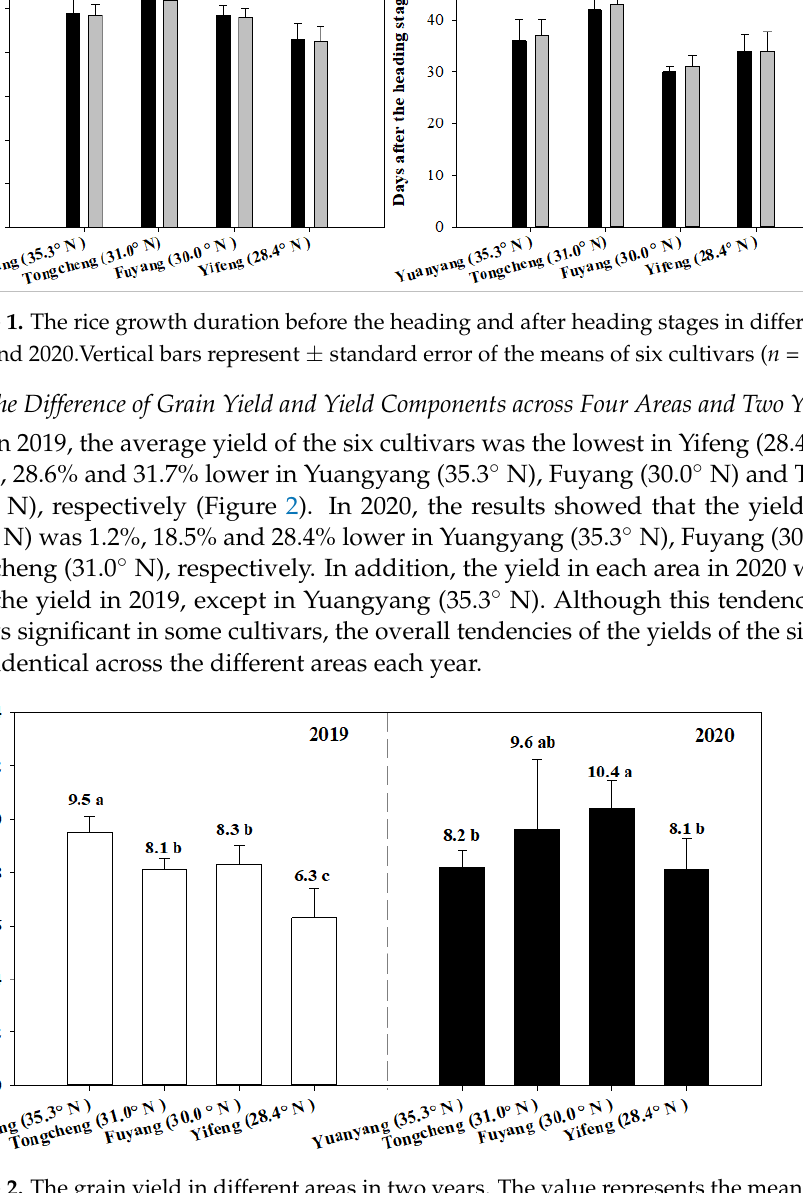
relative panicle m − 2 (RP, r = 0.676, p < 0.001) and the relative grain filling percentage (RGP, r = 0.316, p = 0.041) than with the relative spikelets panicle − 1 (RS, r = 0.242, p = 0.122) and the relative 1000 grain weight (RGW, r = − 0.048, p =